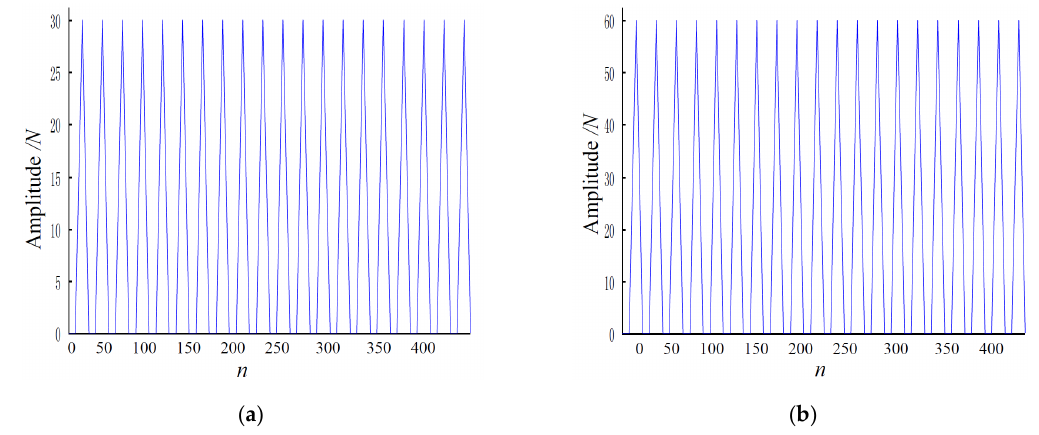
Figure 6. The exciting force in each direction of the rub-impact: ( a ) the exciting force in x -direction; ( b ) the exciting force in y -direction.